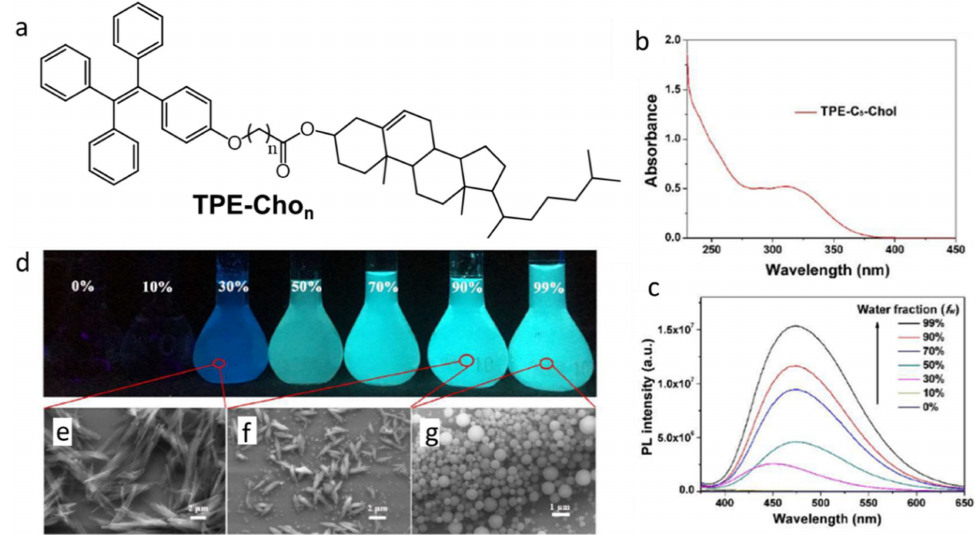
Figure 26. ( a ) Structure of TPE-Cho n (n = 1,4,5,6). ( b ) UV − vis absorption spectrum of 1 × 10 − 4 M TPE-Cho 5 in dichloromethane. ( c ) Emission spectra ( λ ex = 355 nm) of 1 × 10 − 4 M TPE-Cho 5 in different acetone:water mixtures. ( d ) Images under 365 nm radiation of TPE-Cho 5 in acetone:water mixtures, with different water fractions, and SEM images of the aggregates at water contents equal to ( e ) 30%, ( f ) 90% and ( g ) 99%. Reproduced from [92] with permission. Copyright Wiley-VCH GmbH.